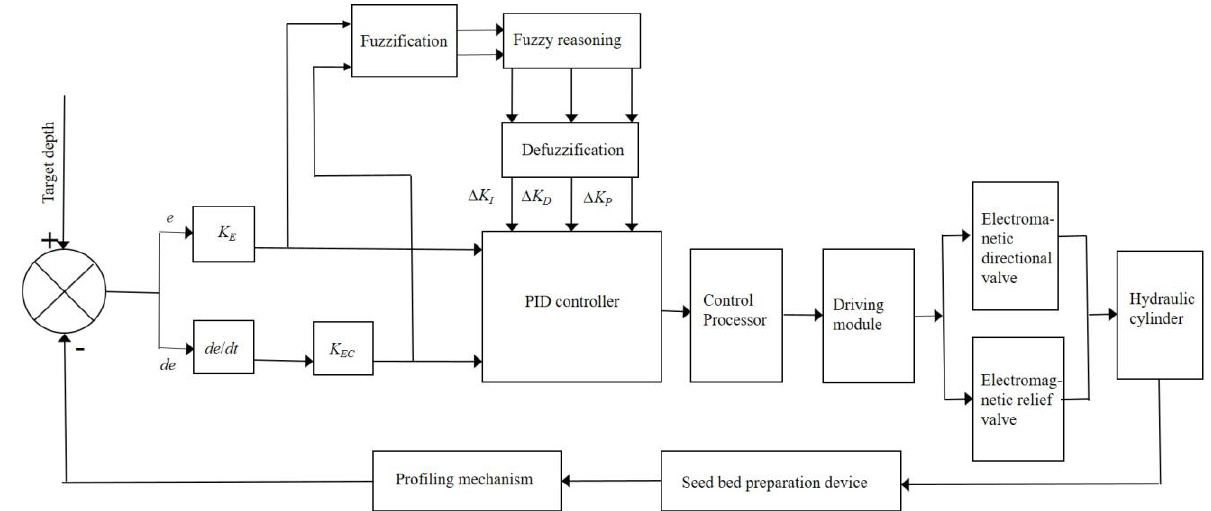
Figure 7. Diagram of the fuzzy PID self-adaptive control system.